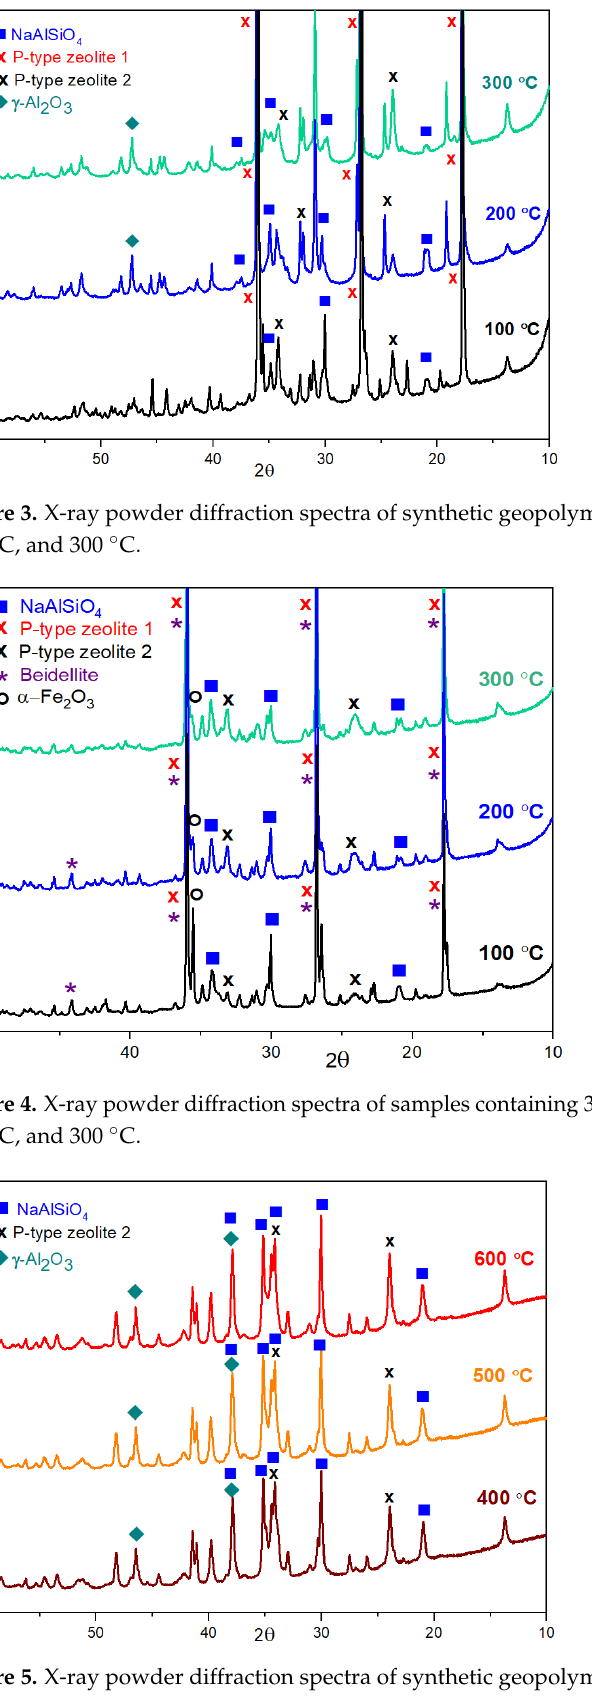
Figure 6. X-ray powder diffraction spectra of samples containing 33% red mud heat-treated at 400 °C, 500 °C, and 600 °C. The intensive changes above 300 °C have also been confirmed by thermal analysis (Figures 7 and 8). A two-step weight loss can be observed up to 480 °C. The first weight loss can be attributed to remaining solvent content after the drying process at 80 °C. The biggest weight loss starts at ~340 °C and finishes at 480 °C. The weight loss of the compo- site samples during this step is 10–15% depending on the chemical composition. The main part of weight loss in this range can be associated with the escape of acetate ions. It has been proven that weight loss is lowest (~10%) in the sample with 33 w / w % red mud and the lowest acetate content. On the DTA curves, there are exothermic peaks at 460–480 °C (Figure 8). These exothermic peaks can be attributed to the combustion of acetate ions and to a crystalline phase transformation, e.g., γ -Al 2 O 3 . All structural examinations, i.e., 27 Al MAS NMR, XRD, and TA, have proven signifi- cant structural changes above 300 °C. The phases of p-type zeolite 1, beidellite, disordered Al oxide/hydroxide, and α -Fe 2 O 3 disappear due to the various processes. The processes may be chemical reactions between the components, resulting in disordered (various sili- cates) and crystalline products (p-type zeolite 2, NaAlSiO 4 ). The other type of process is crystallization ( γ -Al 2 O 3 and then θ -Al 2 O 3 ).